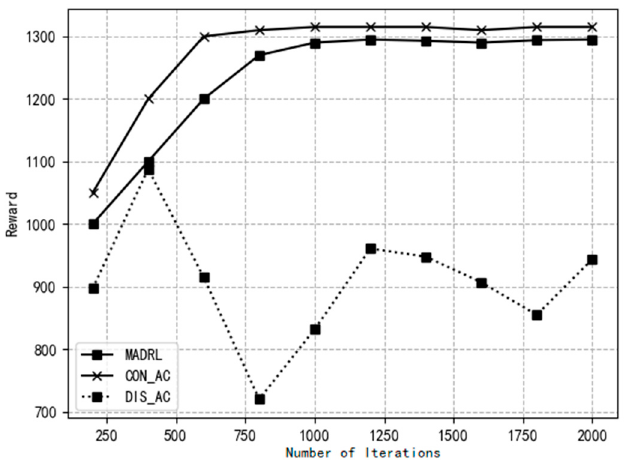
Figure 3. Convergence of different strategy.